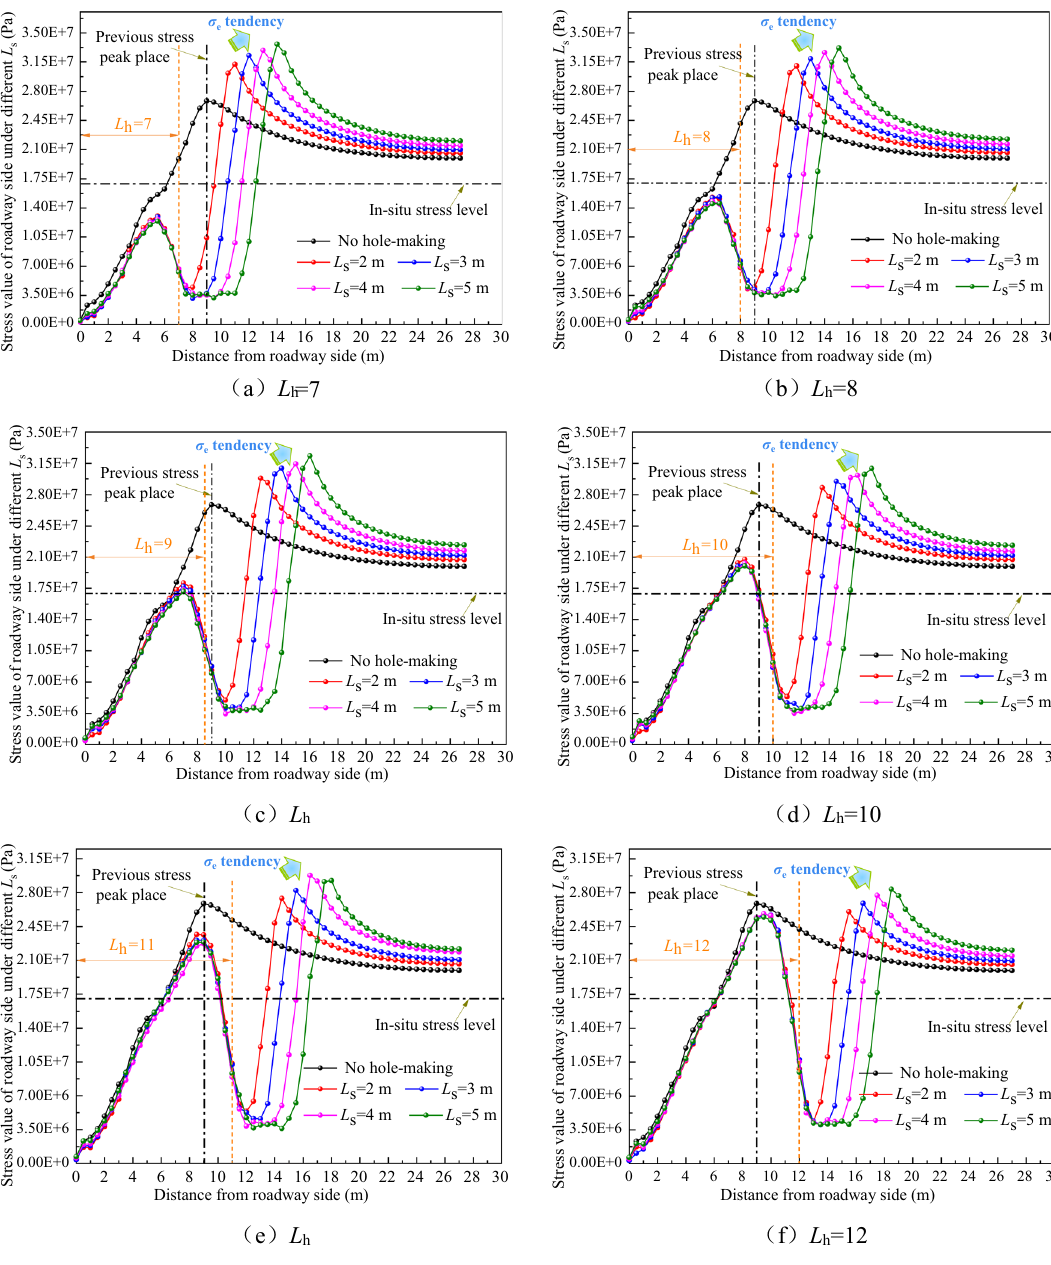
Figure 13. Curve of stress distribution in roadway side rock at different L s.